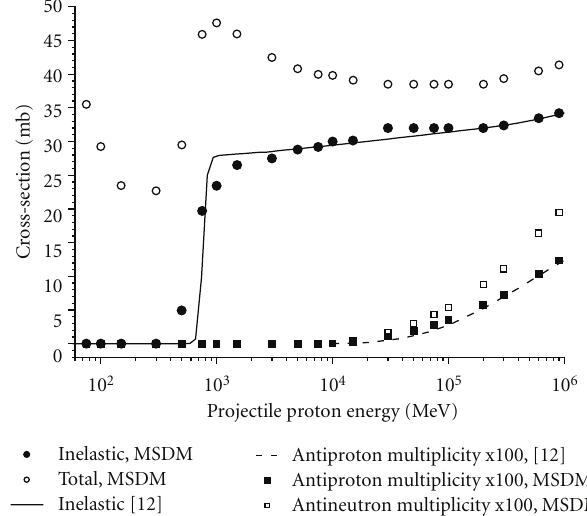
Figure 2: Inelastic, total ( p , H ) cross sections, and multiplicities simulated with the MSDM code compared with the approximation from